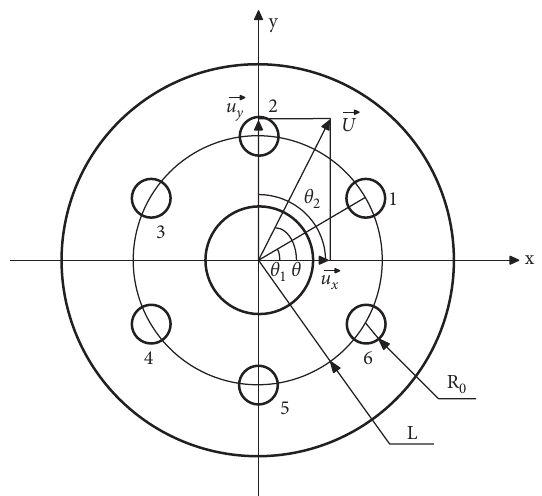
Figure 2: The physical models of reaming hole way.